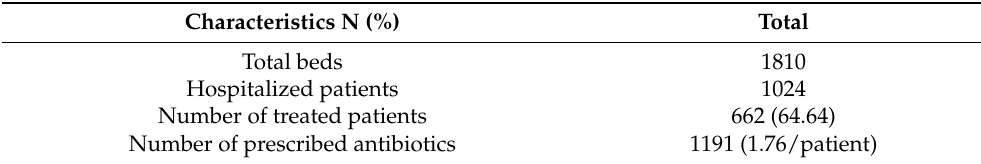
Table 1. Overall antibiotic use